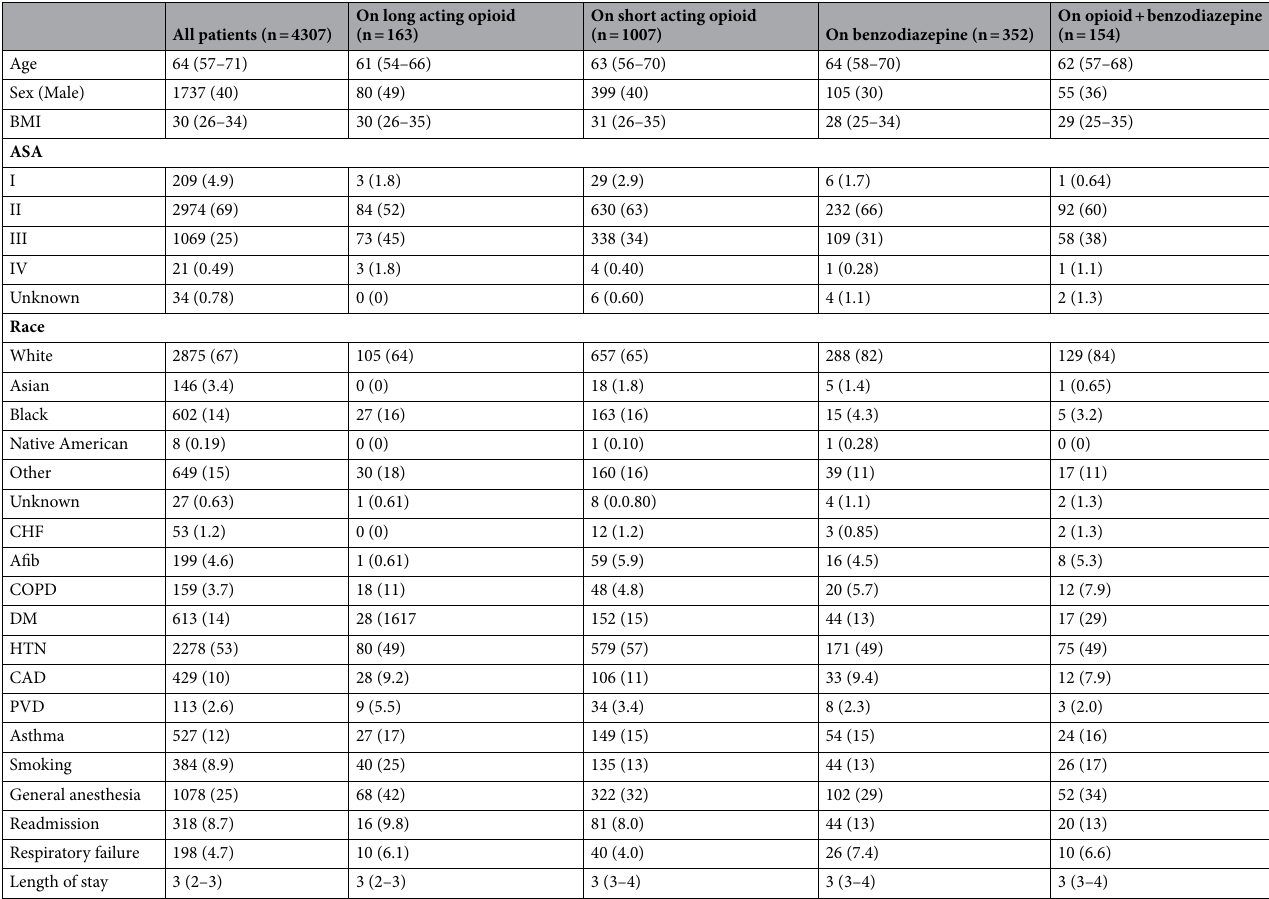
Table 1. Patient characteristics by preoperative medication. Age, BMI, and length of stay are given as median with interquartile range. Other values are number and percentages. BMI body mass index, Afib atrial fibrillation, ASA American Society of Anesthesiologists, CAD coronary artery disease, CHF congestive heart failure, COPD chronic obstructive pulmonary disease, DM diabetes, HTN hypertension, CAD coronary artery disease, PVD peripheral vascular